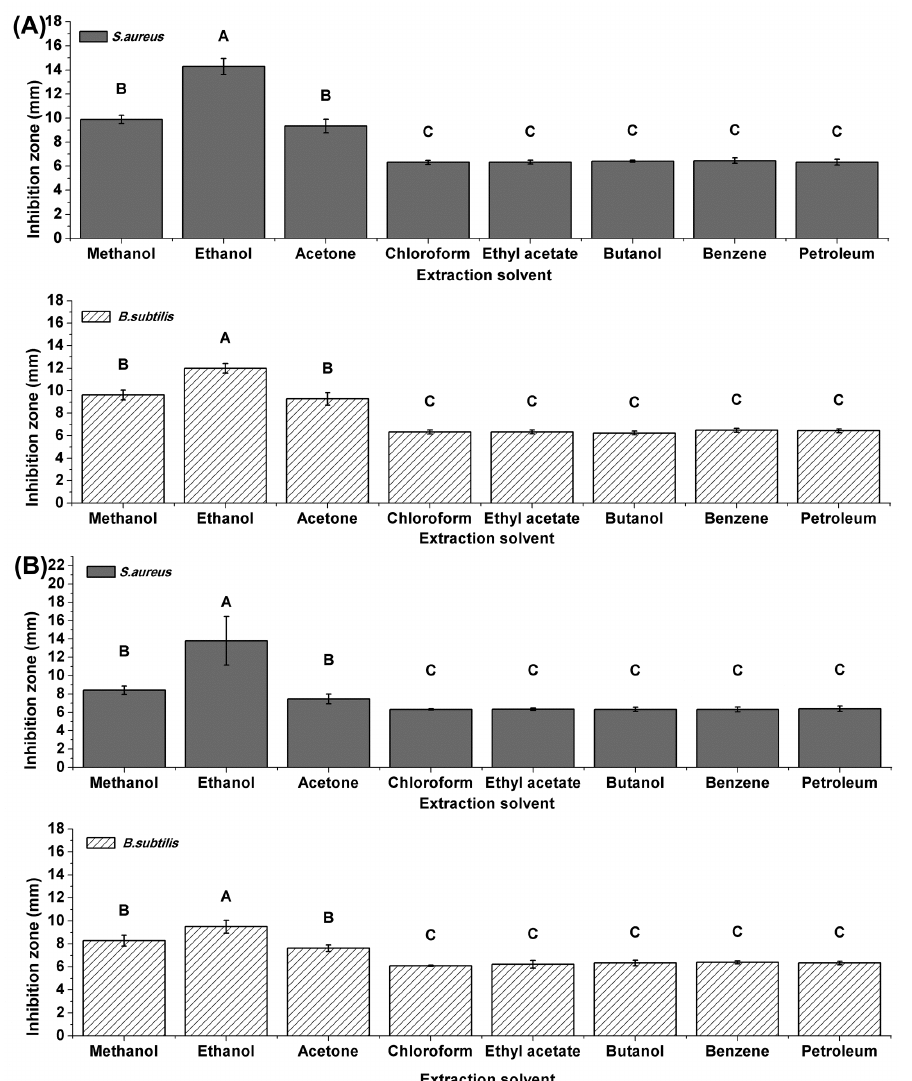
Fig. 1: Antimicrobial activities in extracts from N. obtuse (A) and C. vulgaris (B) against S.aureus and B.subtilis . A negative result was defined as an inhibition zone of 6mm. Greater than 6mm indicated positive result of the presence of antibacterial substance. Inhibition zones of controls were all 6mm. Different letters indicated significant differences (p<0.05; one-way analysis of variance (ANOVA) and Duncan’s multiple range test). Bars represent the means ± standard deviation. Each was replicated nine times.